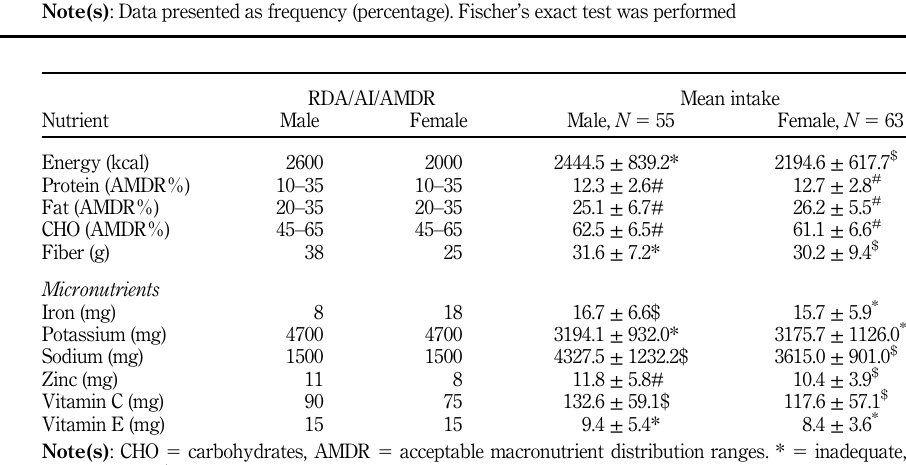
Table 4. Meannutrientintakeof